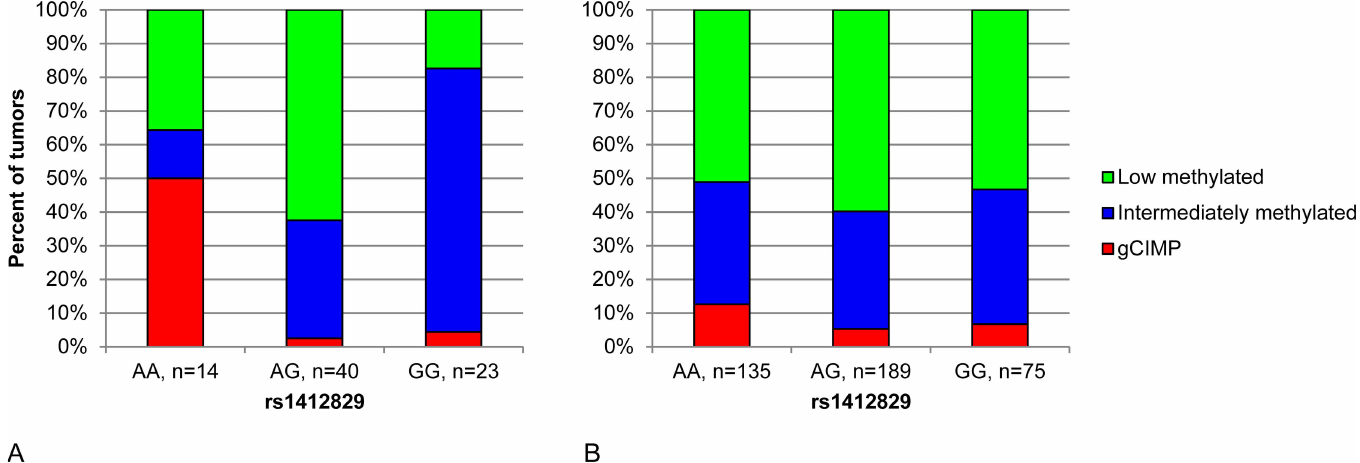
Fig 2. Glioma risk variant rs1412829( CDKN2B-AS1 ) is associated with DNA methylation pattern of the tumor. Distribution of DNA methylation patterns between genotypesin (A) 77 glioma tumors (the pilot dataset), and (B) 399 TCGA glioblastomatumors. P AA vs. AG/GG = 2.59 x 10 − 5 and 0.048 in (A) and (B),